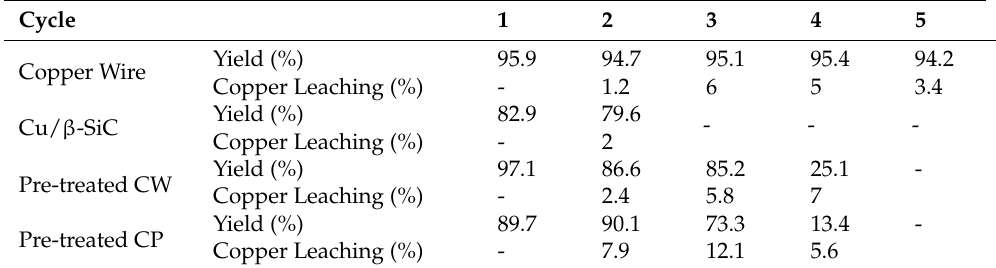
Table 3. Reusability of the heterogenous catalyst in scCO 2 .